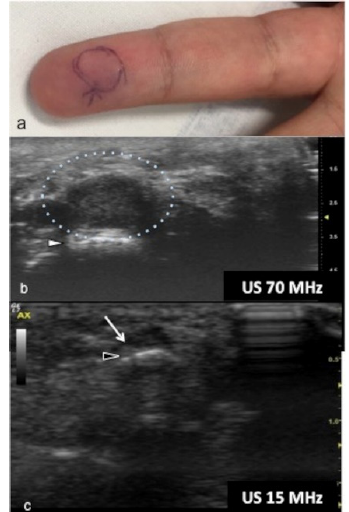
Figure 11. Glomus tumor. The location corresponds to the pulp of finger IV ( a ). The patient had the classical triad of symptoms: paroxysmal pain, pinpoint pain, and cold hypersensitivity, lasting for two years. In ( b ), UHFUS shows a well-delimited nodule in contact with the adjacent phalangeal bone (arrowhead), but no cortical deformity is present. No significant hyperemia on color Doppler was noticed. On CUS ( c ), the nodule was delineated only thanks to the help of the preliminary UHFUS exam.